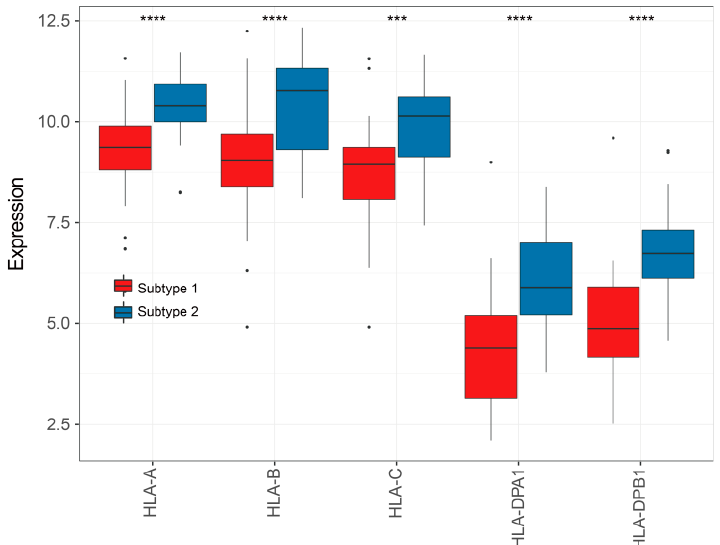
Figure 10. Comparisons of five MHC molecules betweensubtypes1 and 2. Data was analyzed using the Wilcoxon test; *** p < 0.001, **** p < 0.0001.